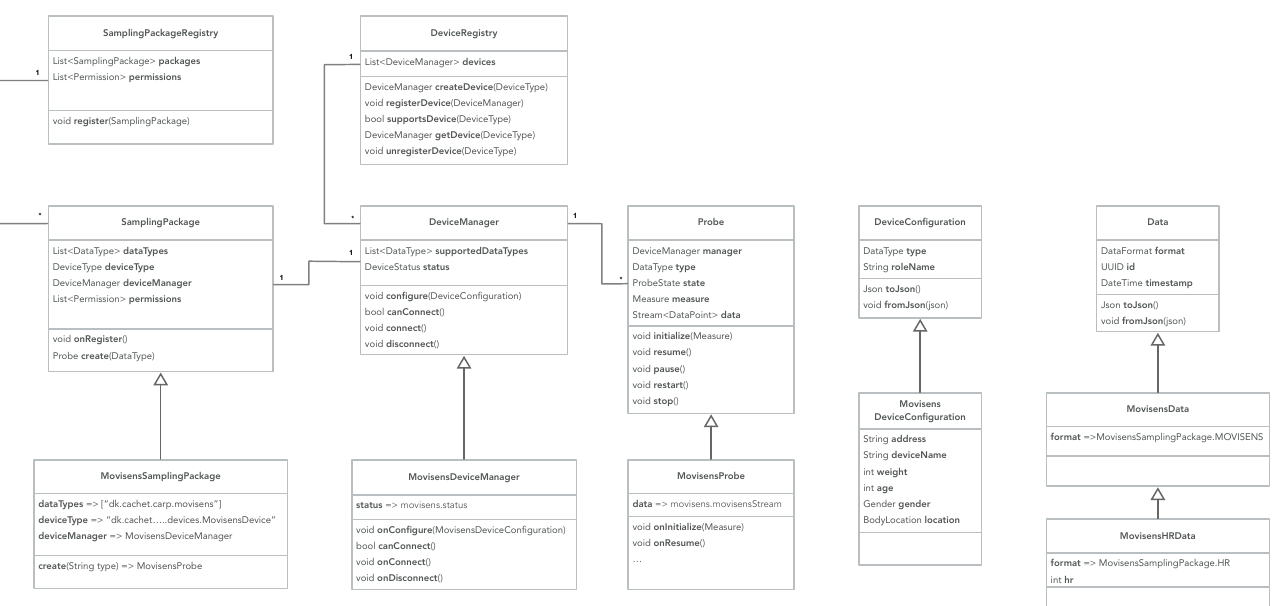
Figure 1. The static UML diagram of the sampling package pattern with the Movisens device as an example. *: